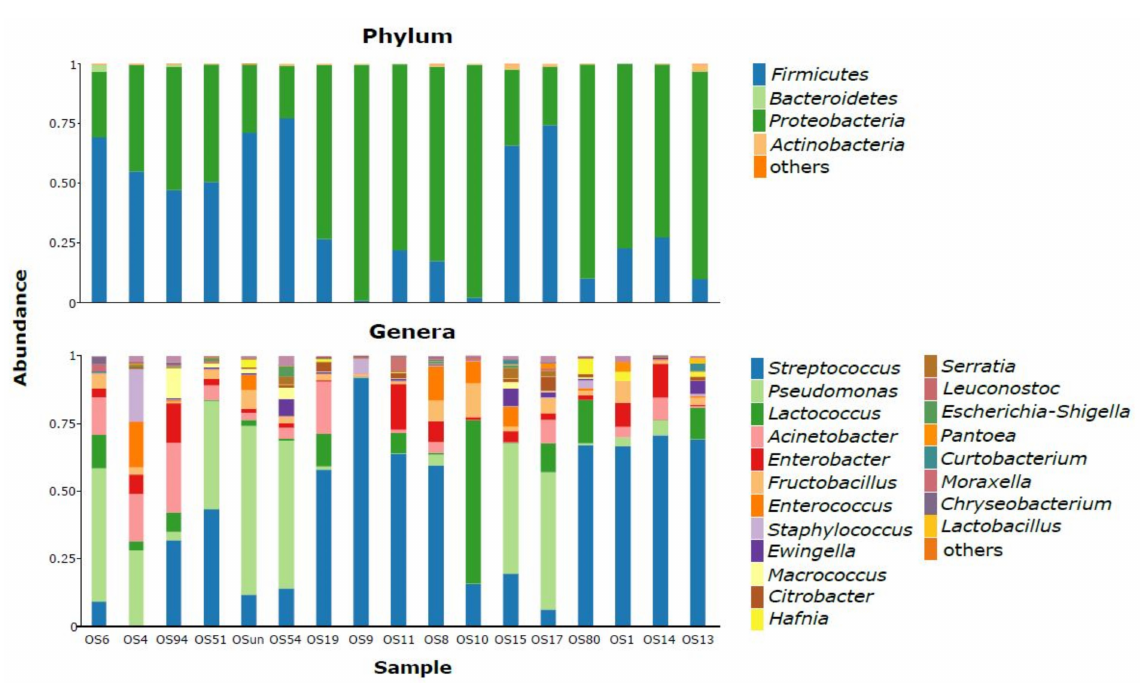
Figure 1. Detection of microbiota at the levels of phyla and genera (individual cheeses are also indicated in Section